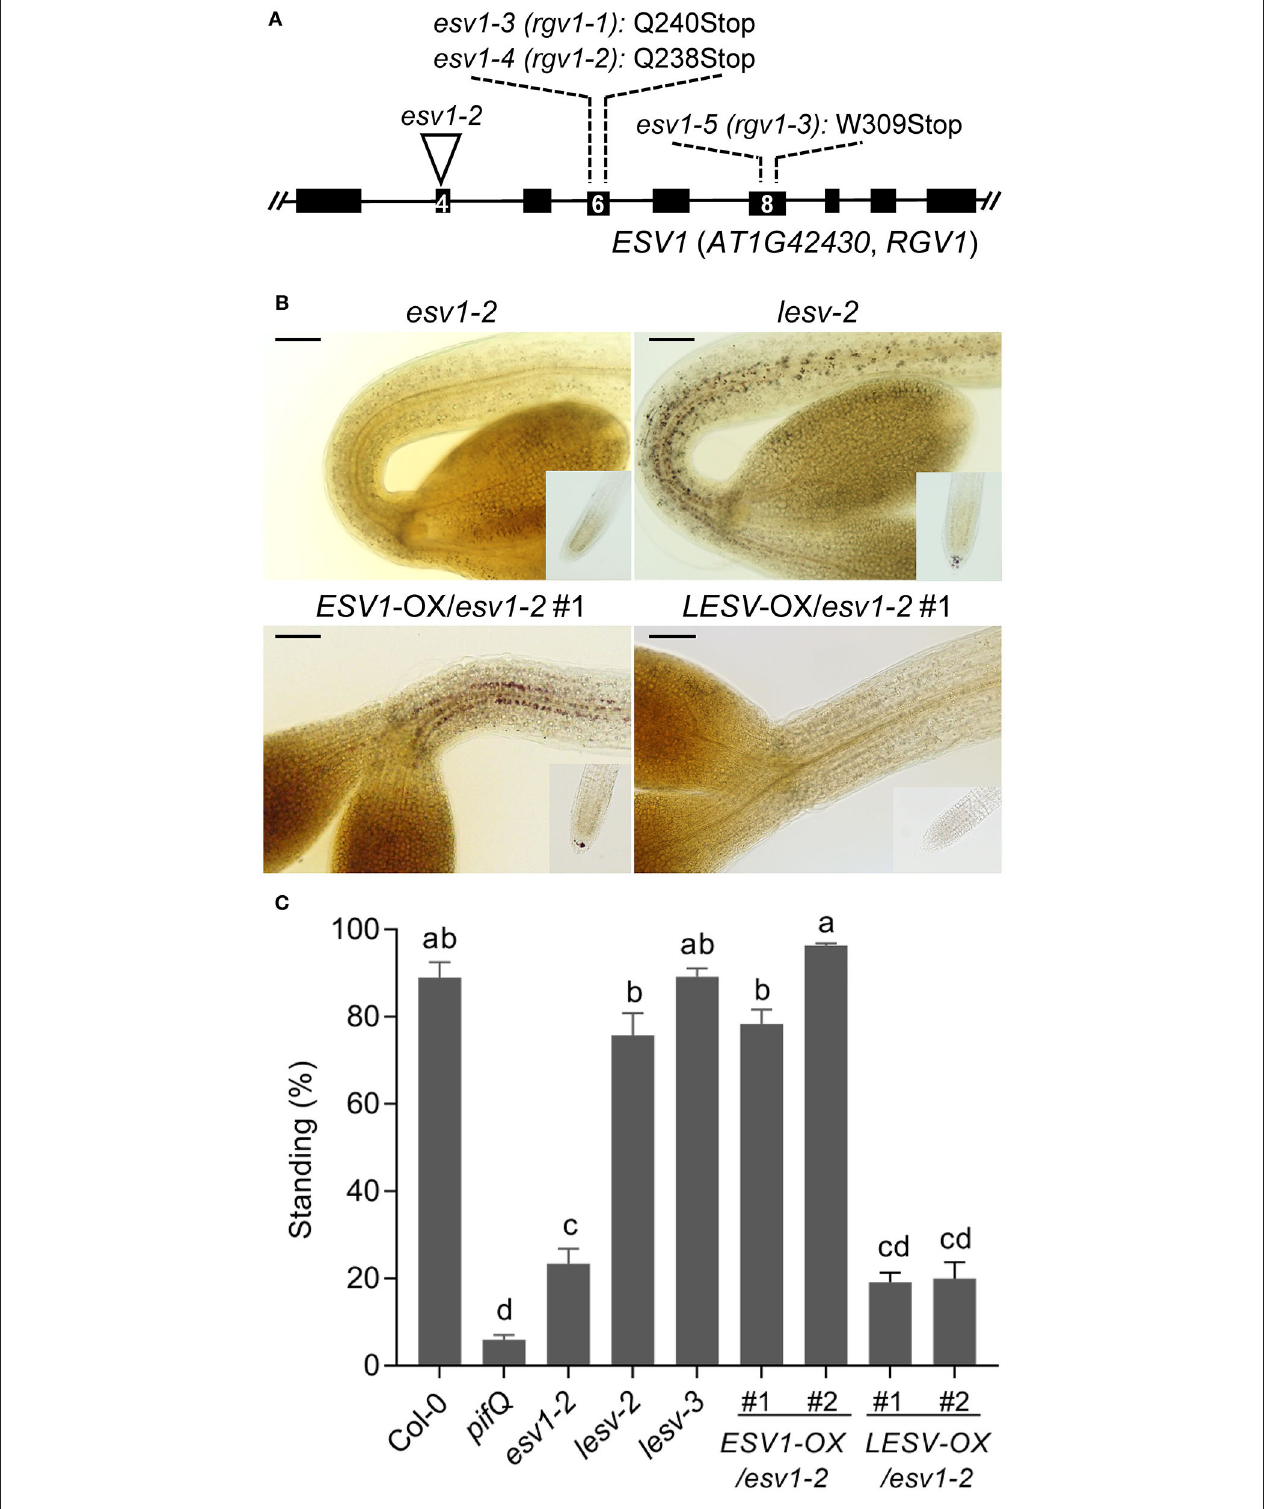
FIGURE 2 | Three reduced gravitropic 1 mutant alleles have non-sense mutations in AT1G42430. (A) A diagram showing these three rgv1 mutant alleles and a T-DNA insertion mutant allele. The mutated loci in these three rgv1 alleles ( rgv1-1, rgv1-2, rgv1-3 ) were determined by whole-genome sequencing. All three rgv1 alleles